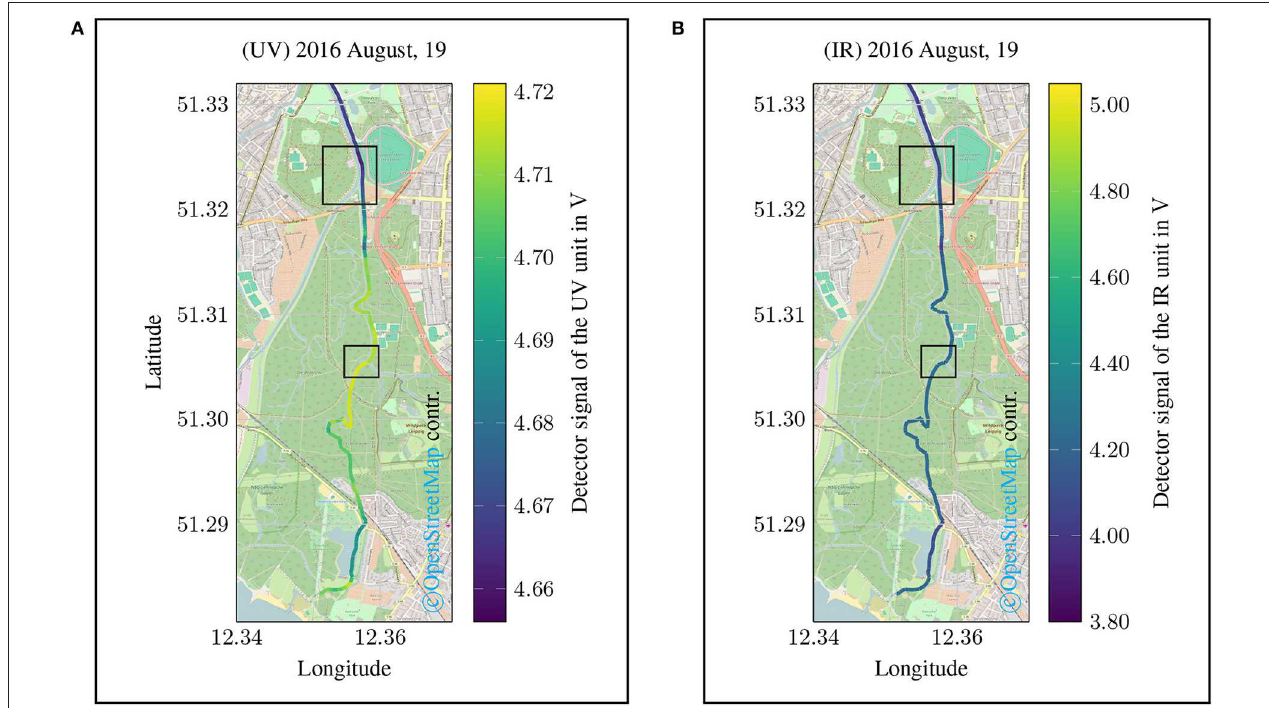
FIGURE 11 | Spatial data plot of a monitoring campaign along a river course (Floßgraben, Pleiße, Elster) in the city area of Leipzig, Saxony, Germany (2016 August, 19). (A) shows the detector signal of the UV channel corresponding to the DOC content. The results of the IR channel are shown in (B) . For both representations, lower values indicate a stronger attenuation due to an increased DOC content or increased turbidity.